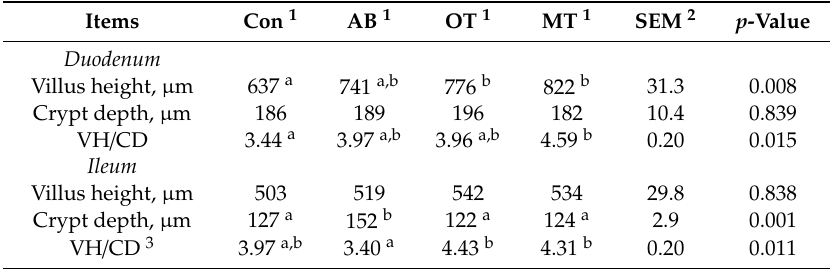
Table 6. E ff ect of dietary supplementation with tributyrin in combination with di ff erent essential oils on small intestinal morphology of weaned